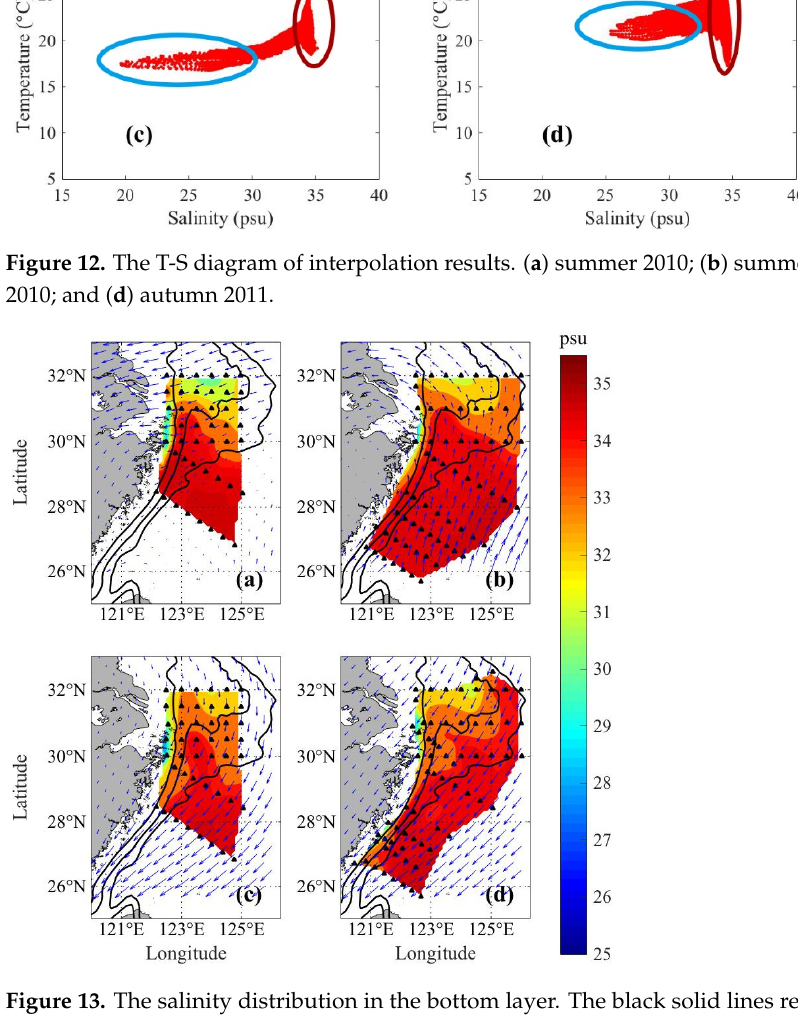
Figure 13. The salinity distribution in the bottom layer. The black solid lines represent the − 30 m, − 50 m, and − 70 m isobaths. The blue arrows are the wind field and the stations are depicted with the black triangles in the picture. ( a ) Summer 2010; ( b ) Summer 2011; ( c ) Autumn 2010; and ( d ) Autumn 2011.